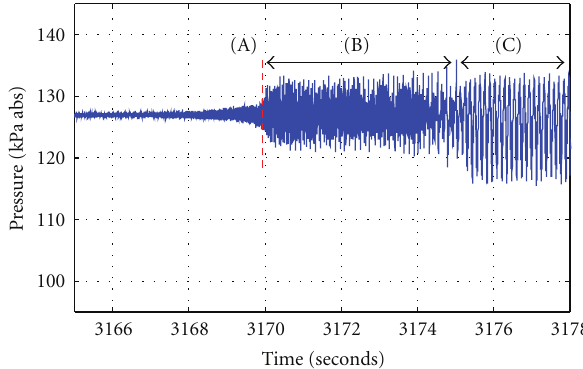
Figure 10: Pressure fluctuations in the compressor during the onset of surge at 16,000 rpm: (A) instability initiation—observed audible sound change, (B) initial pressure fluctuations at a frequency near 21Hz, and (C) pressure fluctuations changed to a lower frequency near 7 Hz as throttle valve closed